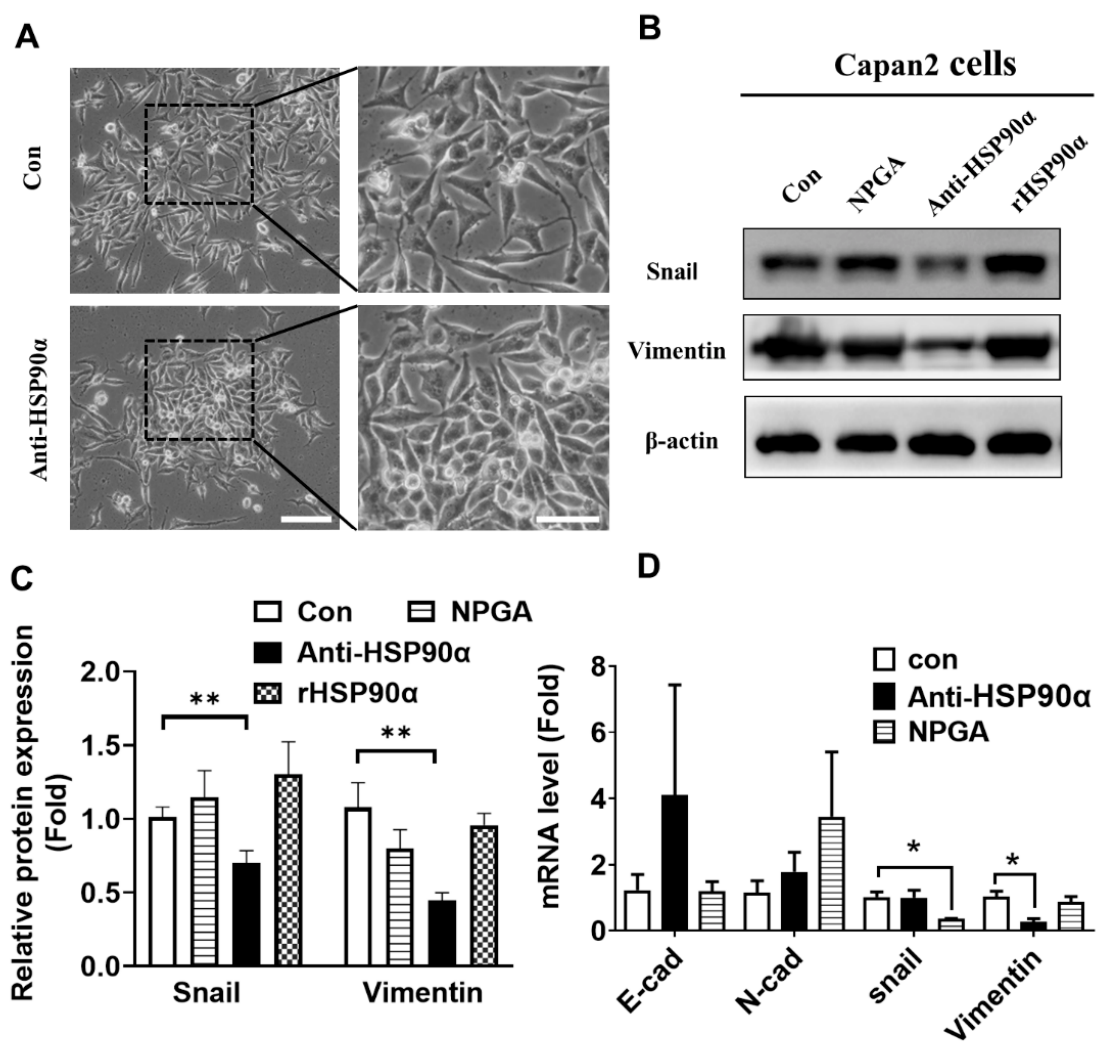
Figure 4. The anti-HSP90 α neutralizing antibody reverses epithelial–mesenchymal transition (EMT) in PC cells. ( A ) The cell morphology after administration of the anti-HSP90 α antibody (5 µ g/mL) for 72 h in Capan-2 cells. Scale bar, 5 µ m. ( B ) The immunoblot analysis of mesenchymal proteins, including vimentin and Snail, after treatment with the anti-HSP90 α antibody or NPGA in Capan-2 cells. ( C ) The relative protein levels are shown in the histogram. Data are expressed as the mean from three experiments. ** p ≤ 0.01. ( D ) The E-cadherin, N-cadherin, vimentin, and Snail mRNA expressions in anti-HSP90 α antibody-treated or NPGA-treated Capan-2 cells were validated by qRT-PCR. Data are expressed as the mean from three experiments. * p ≤ 0.05.